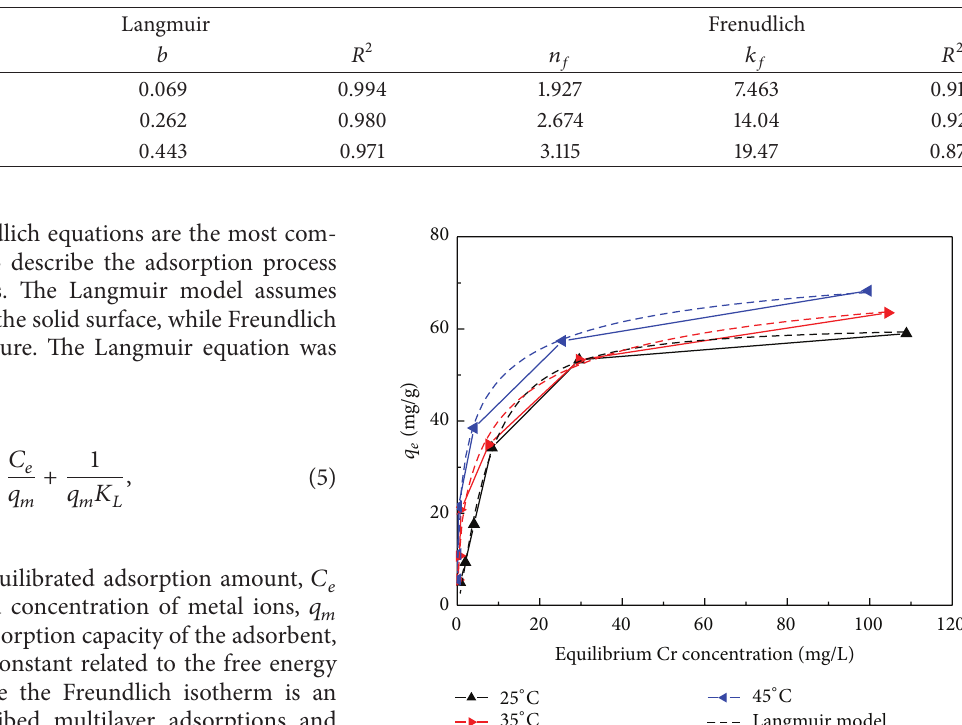
-MCM-41 in different temperature. 2